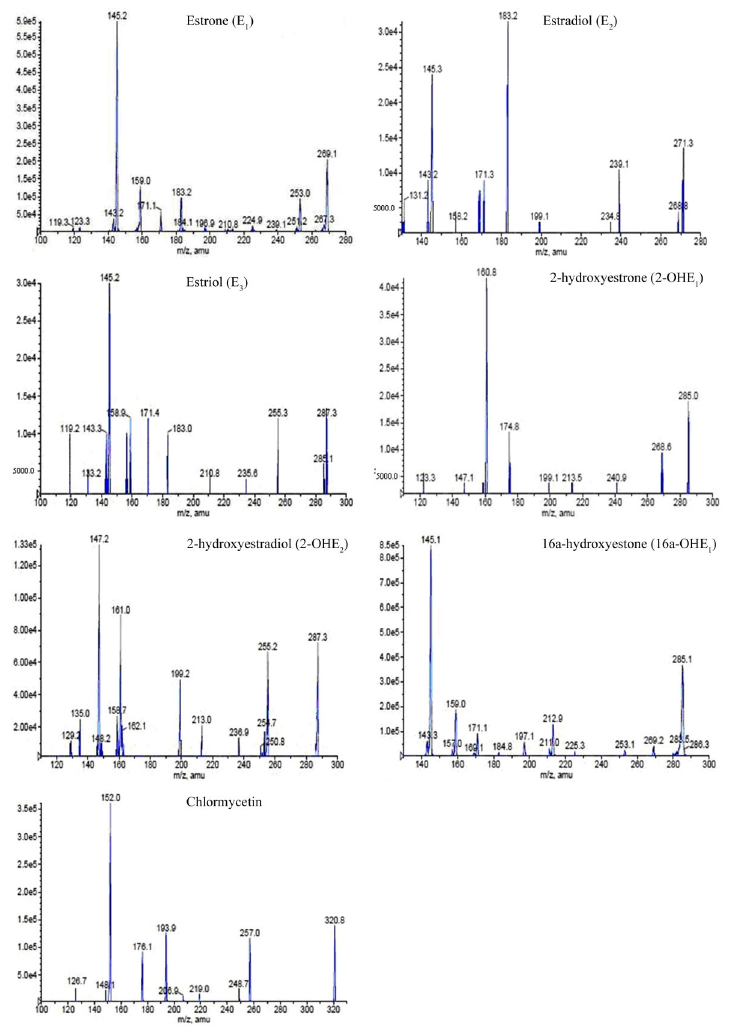
Figure 3. Product mass spectrum of EMs and internal standards. E 1 : estrone; E 2 : estradiol; E 3 : estriol; 2-OHE 1 : 2-hydroxyestrone; 2-OHE 2 : 2- hydroxyestradiol; 16a-OHE 1 : 16a-hydroxyes- trone;